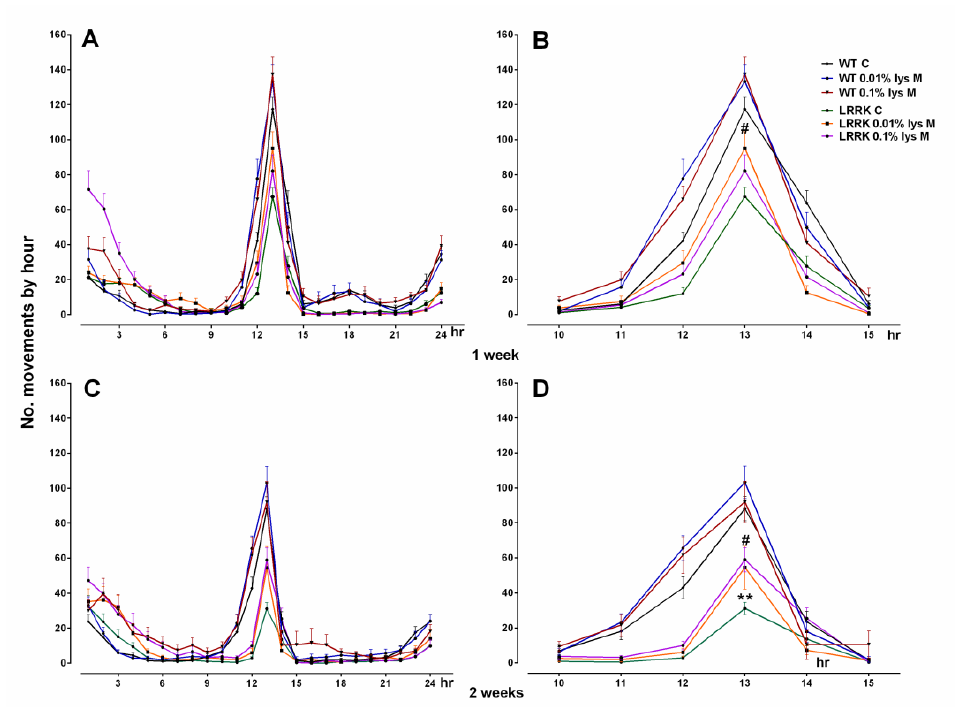
mDLE. # = p < 0.001 LRRK strain versus WTs and ** = p < 0.001 LRKK C versus LRRK fDLE-treated (0.01%, Tukey’s = p < 0.001 LRRK strain versus WTs Tukey’s test).